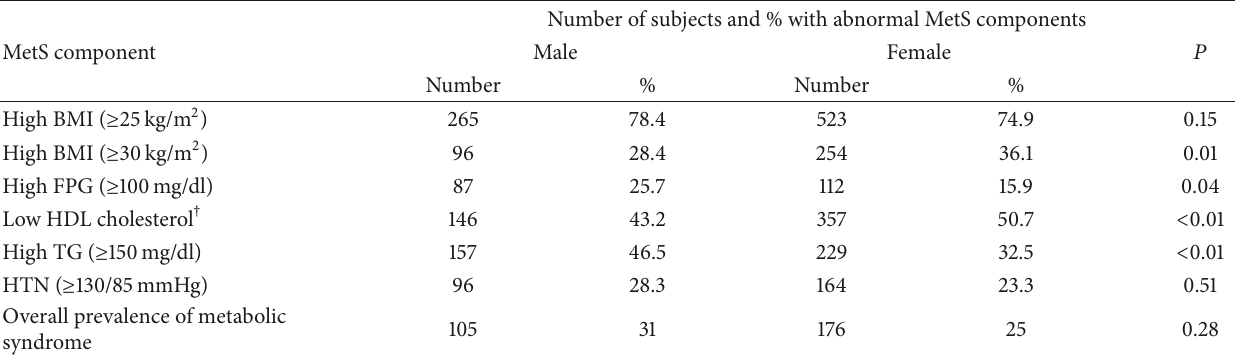
Table 3: Prevalence of individual Metabolic Syndrome components among male and female Central and South